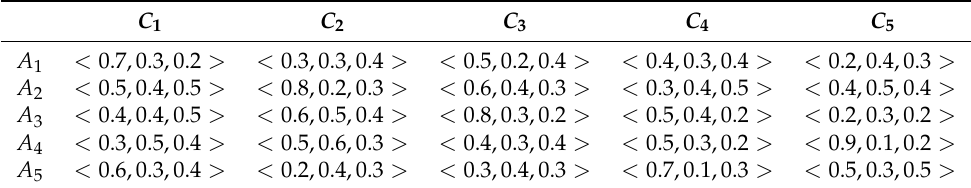
Table 1. The decision matrix. C